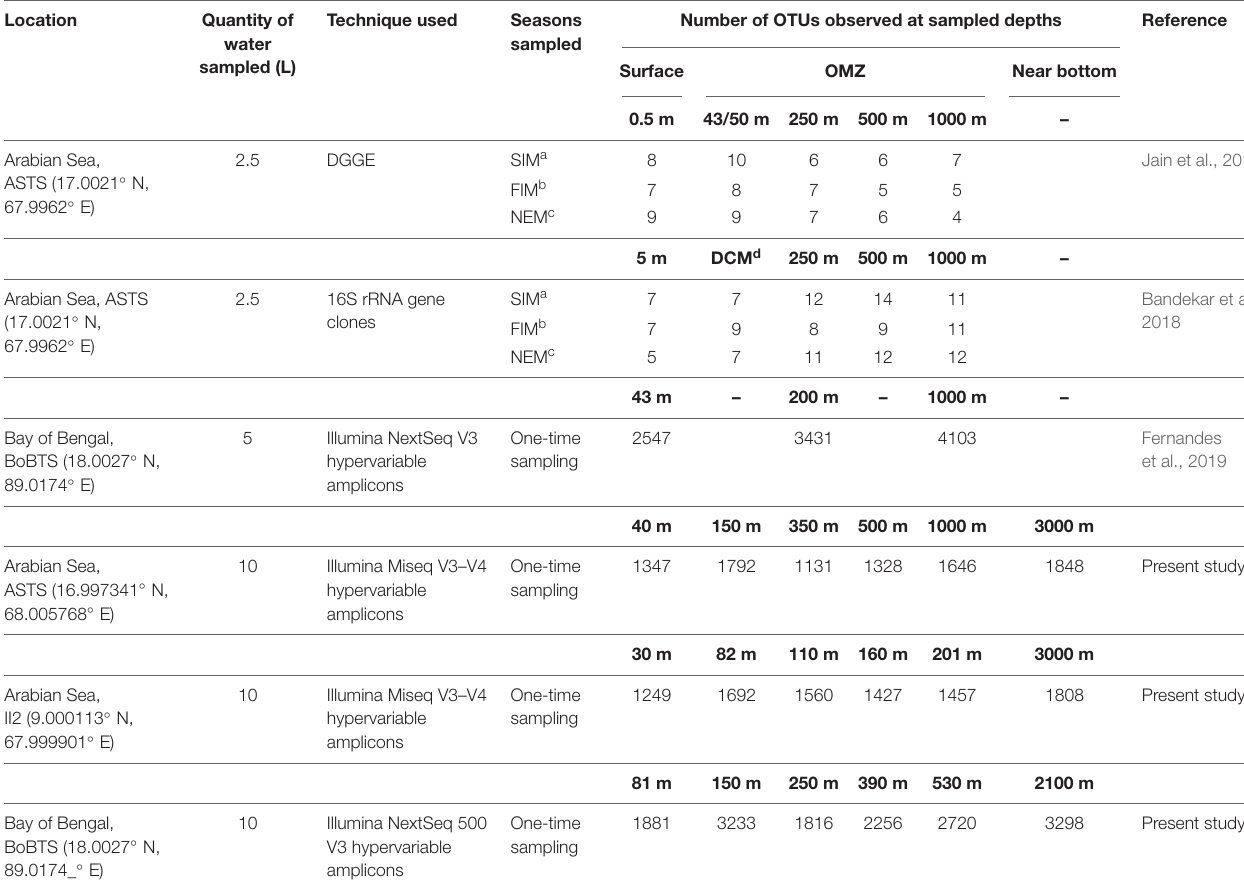
TABLE 2 | A comparative representation of metagenomic techniques used to obtain observed OTUs in the water column from ASTS and BoBTS OMZ locations. Location